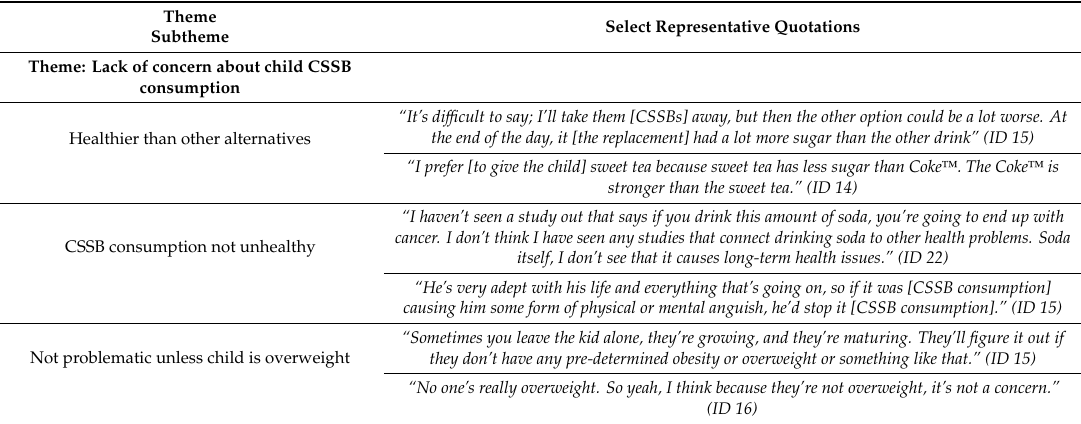
Table 3. Parents’ Lack of Concern about Child Ca ff einated Sugar-Sweetened Beverage (CSSB) Intake. Theme